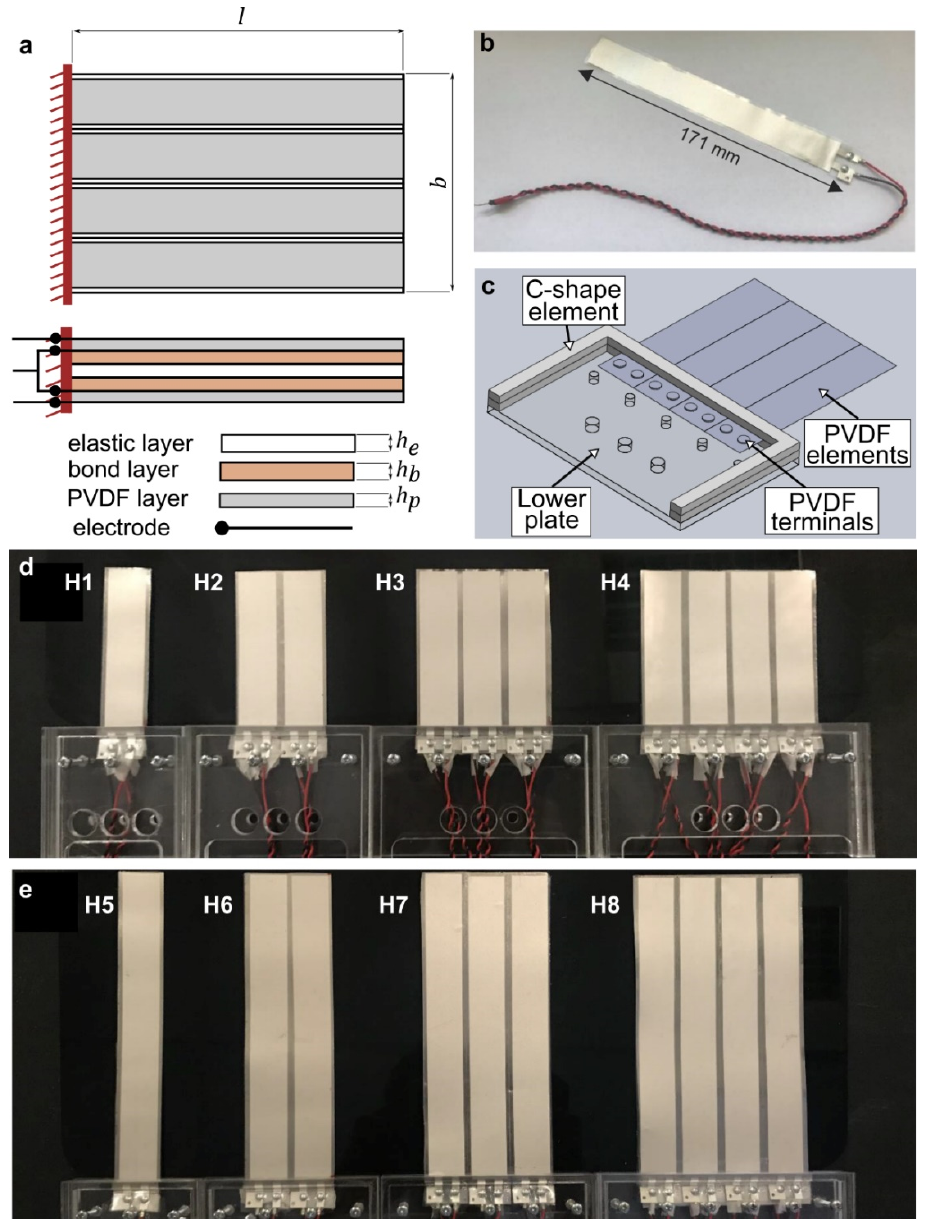
Figure 1. The harvesters considered in this study: ( a ) design schematics (the example shown includes four polyvinylidene difluoride (PVDF) elements on each side); ( b ) one PVDF element; ( c ) schematic representation of the custom-made mounting system to connect the harvester to the shaker (the upper plate is removed to show internal details); ( d ) harvesters H1–H4 with length of 78 mm; ( e ) harvesters H5–H8 with length of 155 mm.